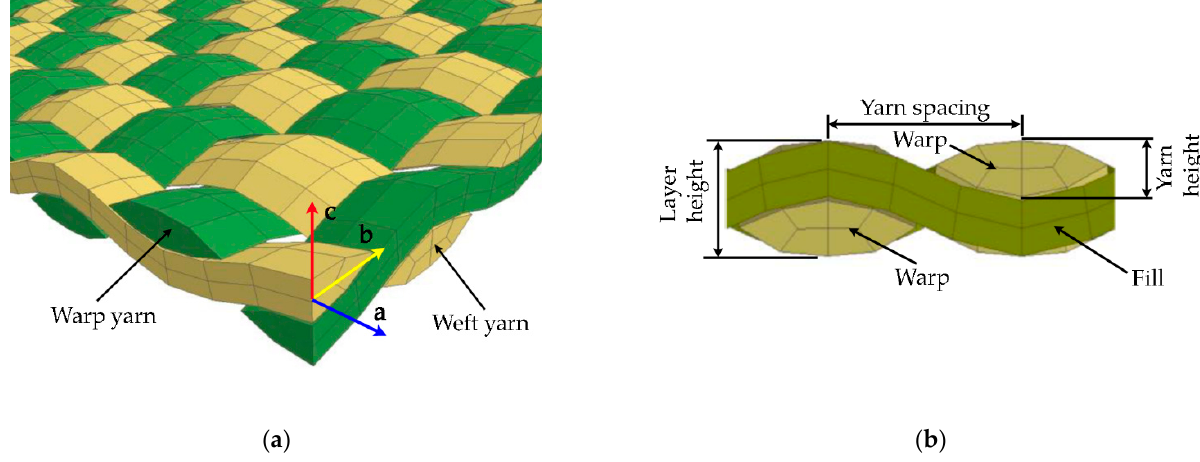
Figure 11. Discretization of Twaron CT 750 fabric: ( a ) Schematic of a plain-woven and ( b ) plain woven textile showing the warp and fill.